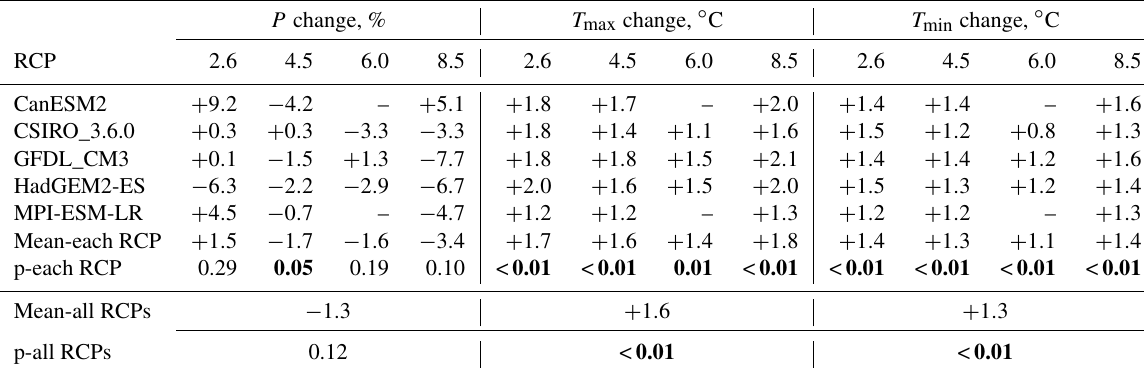
Mean-each/all RCP, average changes for all ESMs under one/all RCP; p-each/all RCP, significance of t test for all ESMs under one/all RCP. The data in bold font indicate that changes are significant ( p < 0 . 05